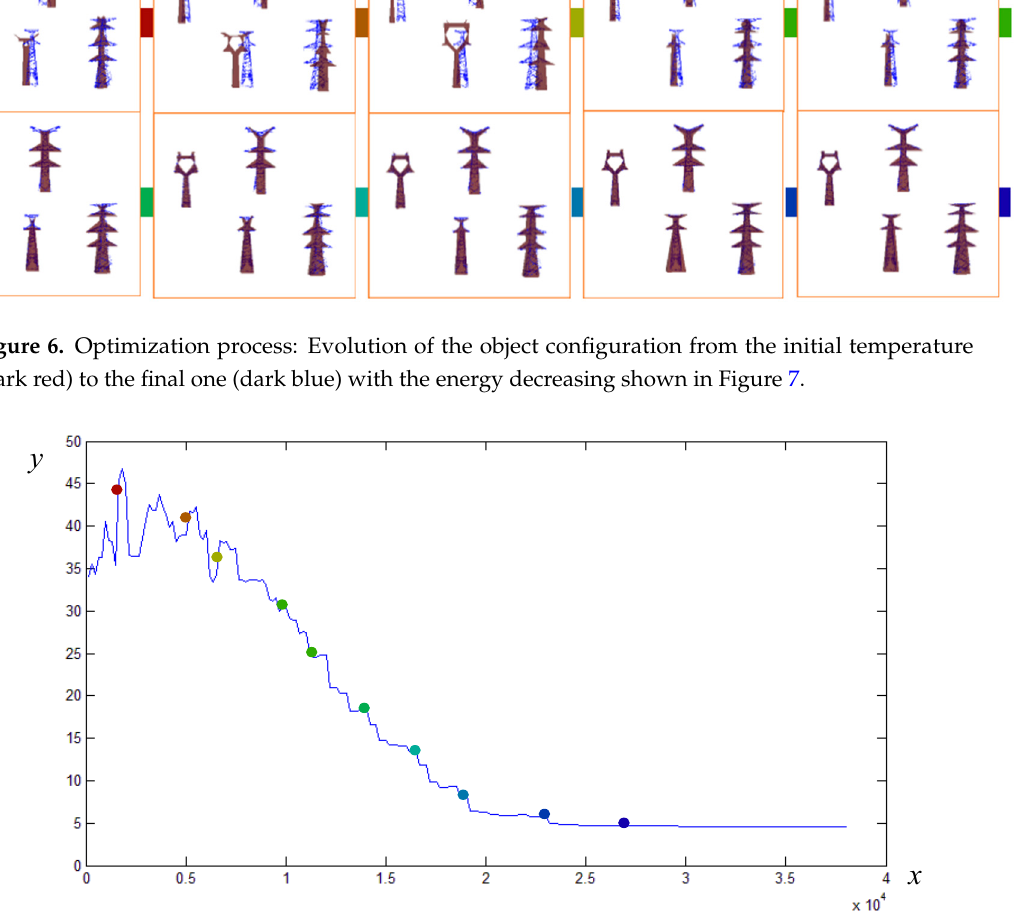
Figure 7. Energy decrease, x = t and y = U , where the circles with different colors represent the temperature corresponding to the optimization process shown in Figure 6.